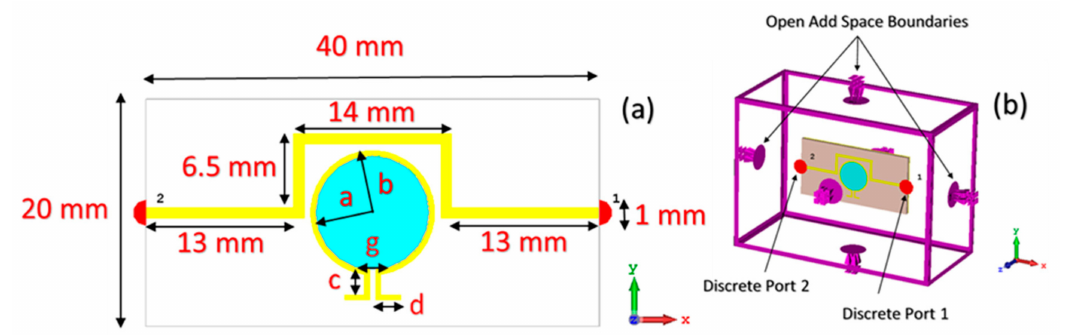
Figure 2. MTM based liquid sensor design: ( a ) design dimensions; ( b ) boundary conditions and added port of each side of the transmission line at simulation